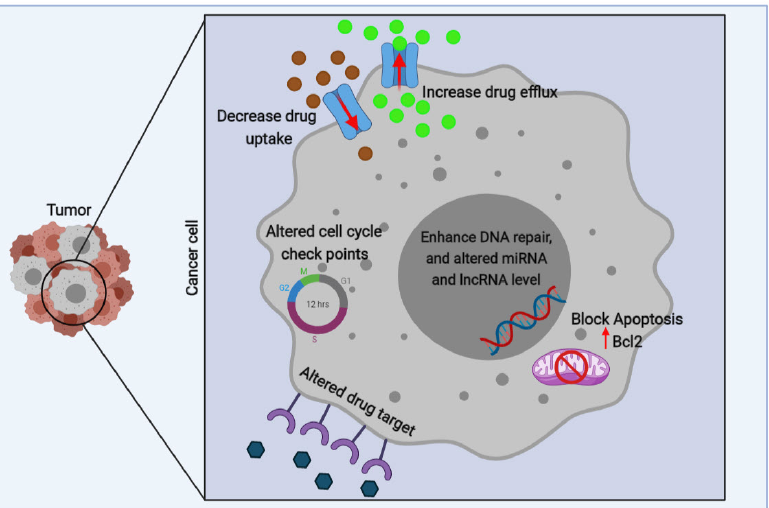
Figure 3. A scheme of the mechanisms involved in multidrug resistance in tumor cells. The mech- anisms involved in multidrug resistance (MDR) overexpression include 1. An increase in ATP- binding cassette (ABC) transporters which increases drug efflux, which reduces intracellular drug concentration. 2. Reducing drug uptake by influx transporters. 3. Blocking apoptotic signaling pathways and increase anti-apoptotic (B-cell lymphoma 2) Bcl2. 4. Enhancing DNA repair and increasing adaptability by miRNA and lncRNA regulation. 5. Mutations in drug targets. 6. Aber- rant expression of cell cycle checkpoints.